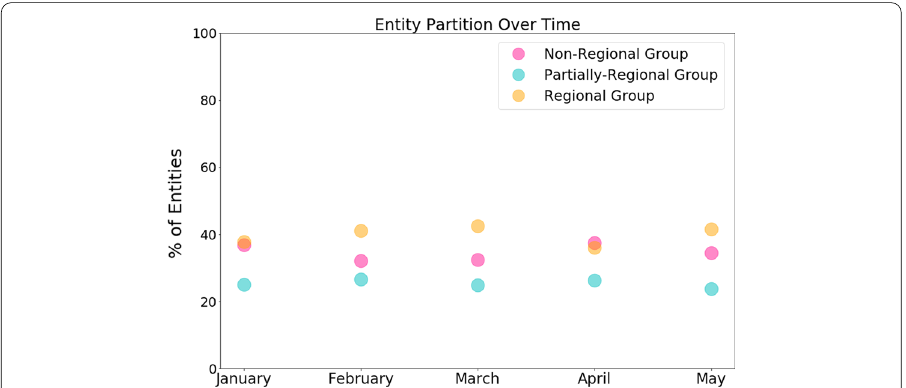
Fig. 6 Partition group size over time. The Non-Regional group consists of funding entities with no regionally-dominated ads, the Regional group consists of funding entities with at least 99% of their ads regionally-dominated, and the Partially-Regional group consists of all other funding entities. For each month, we calculate group sizes by only considering the ads published during that month